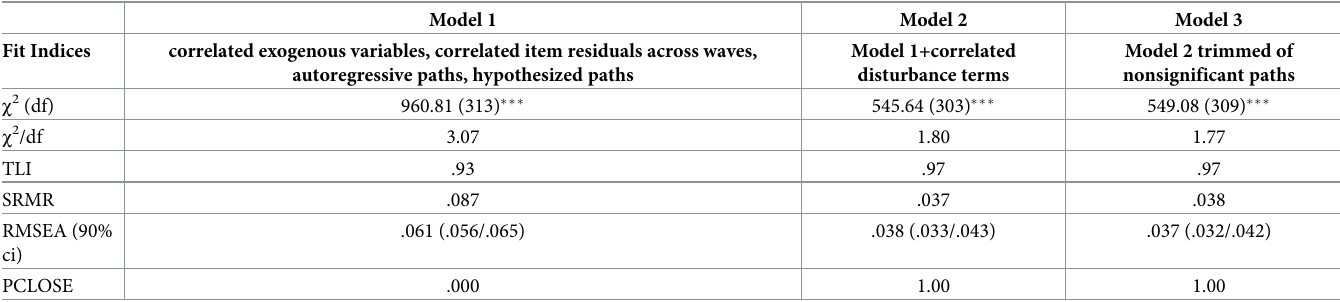
Table 3. Theoretical models of fear and emotional